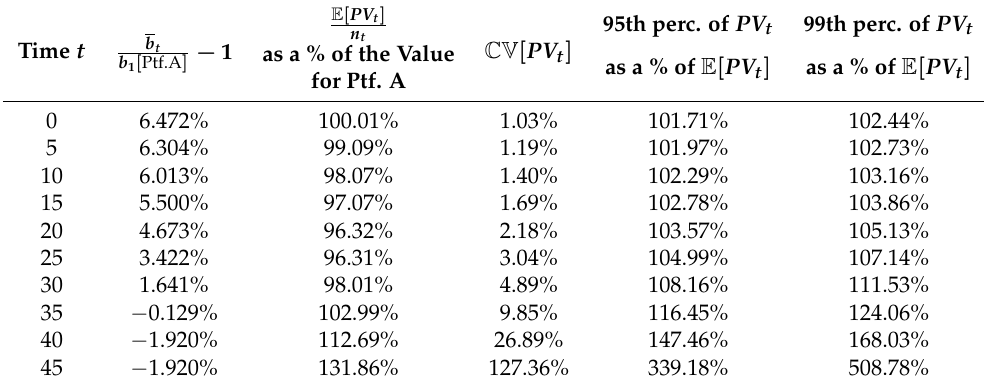
Table 22. Portfolio I: portfolio average benefit amount (additional amount with respect to the standard benefit for Portfolio